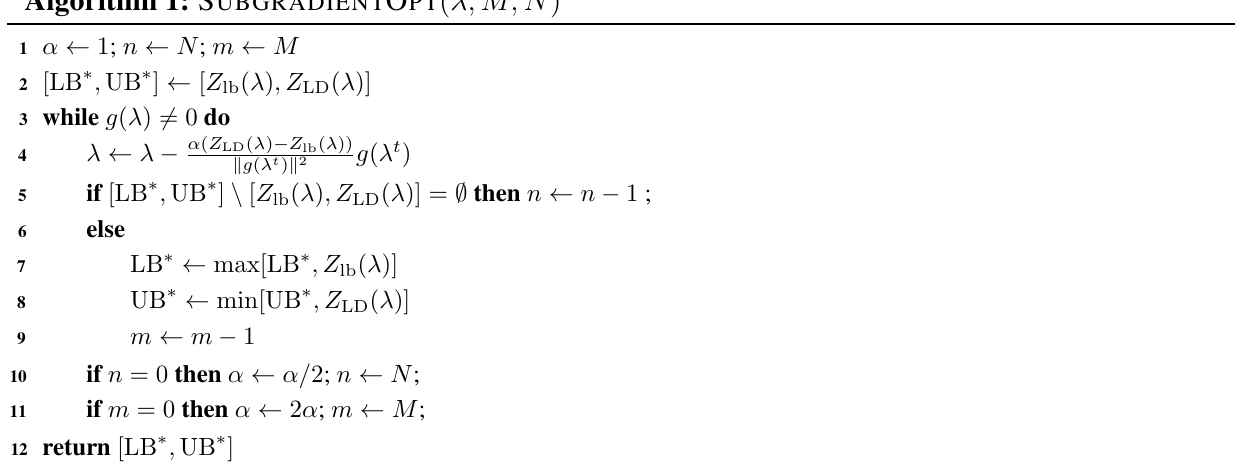
Algorithm 1: S UBGRADIENT O PT ( λ, M, N